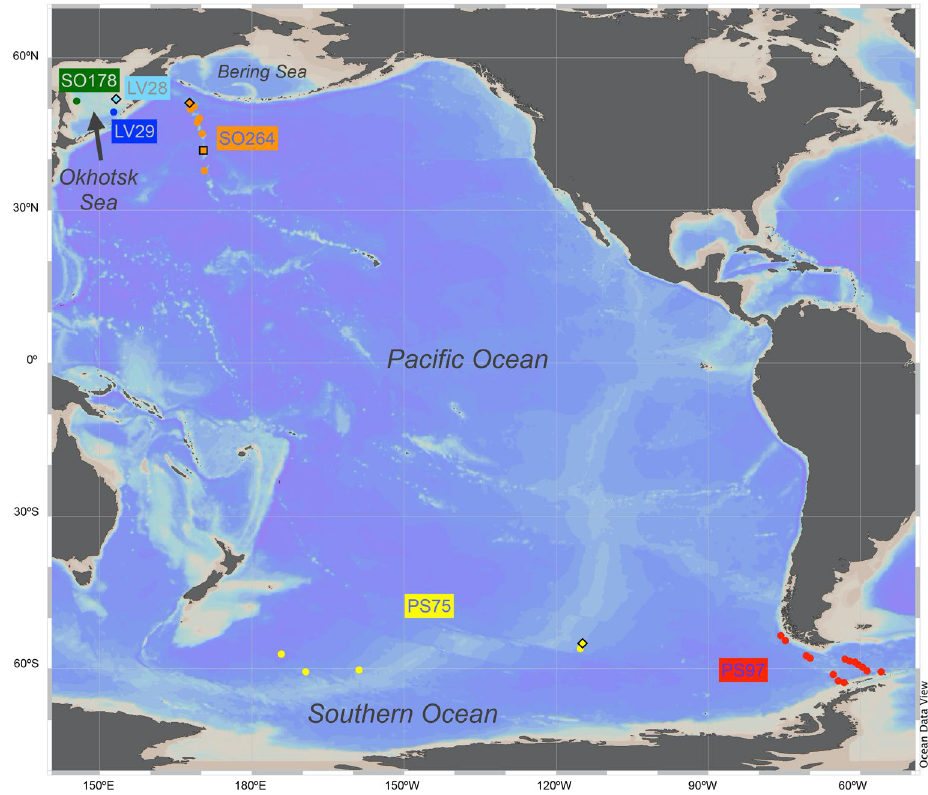
Figure 1. Map of selected pelagic sediment cores, marked by colored dots related to individual and labelled cruises. The orange square represents the pilot test core SO264-15-2. The diamonds represent the cores PS75/056-1, LV28-44-3 and SO264-69-2 used in the case study. Map is created with Ocean Data View 5.6.3 (https:// odv. awi.